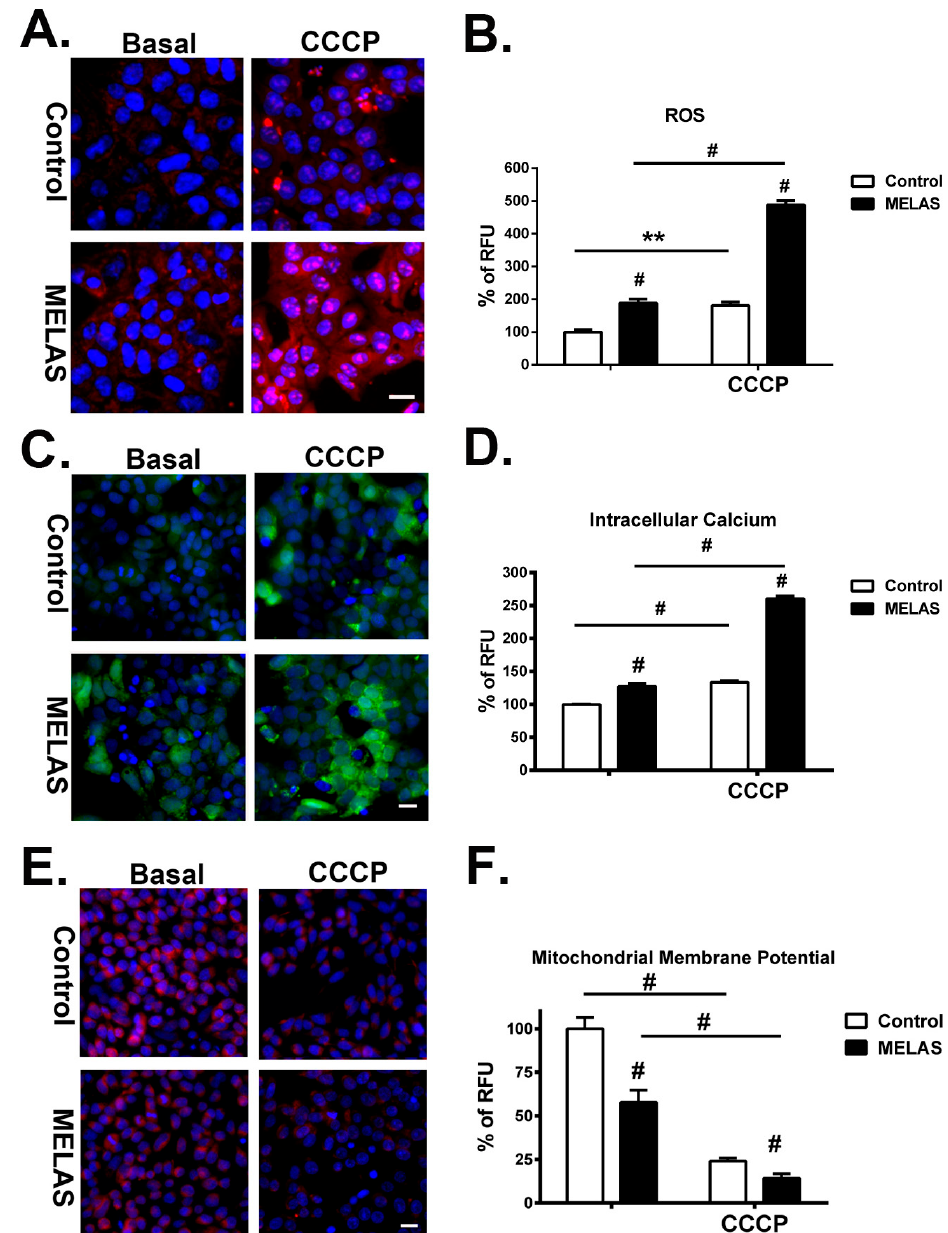
Figure 3. Increase of reactive oxygen species (ROS), intracellular calcium, and mitochondrial depolarization in MELAS iPS cells. ( A ) Representative microscopy fluorescence images showing levels of ROS by staining with MitoSox Red in iPS cells in the presence or absence of CCCP. ( B ) Quantification of ROS levels by analyzing the fluorescence intensity of MitoSox Red. ( C ) Representative microscopy fluorescence images showing levels of intracellular calcium by staining with calcium-sensitive fluorescent dye, fluo-8, in iPS cells in the presence or absence of CCCP. ( D ) Quantification of intracellular calcium levels by analyzing the fluorescence intensity of fluo-8. ( E ) Microscopy fluorescence images showing levels of mitochondrial depolarization by staining with tetramethylrhodamine ethyl ester (TMRE) in iPS cells in the presence or absence of CCCP. ( F ) Quantification of mitochondrial depolarization levels by analyzing the fluorescence intensity of TMRE. All measurements, normalized for number of cells, are expressed as mean values ± SEM, n = 3–5. ** p < 0.01, # p < 0.001, versus control. RFU: relative fluorescence unit. Scale bar: 20 μ m.